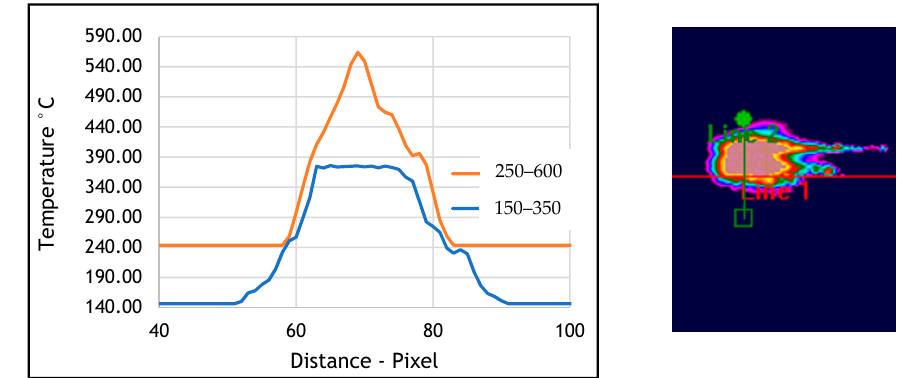
Figure 9. Thermal images and temperature profile of the steel block. BN tube with φ int = 4 mm, N 2 = 35 L/min, microwave forward power 15 kW, plasma ON time = 2 s.